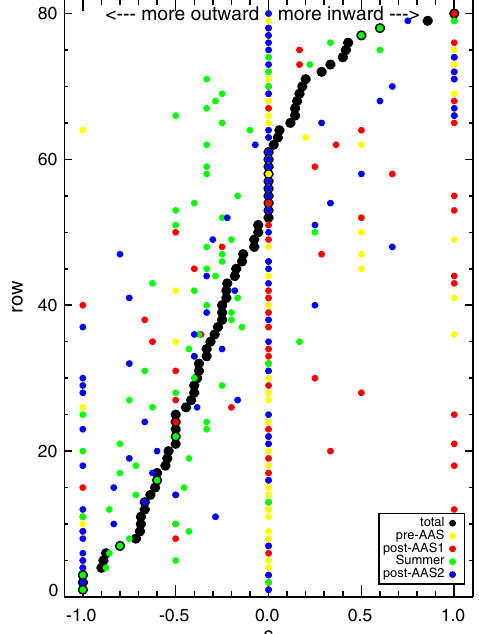
FIG. 2. The metric s (see text). The y axis is, in essence, an assigned teacher number; the teachers have been sorted by s before plotting. Black points are the metric calculated over all instances of that educator for that team ( s ); yellow points are total the metric calculated from the pre-AAS survey (only available for the 2015 class and later), red points are the post-first-AAS survey (post-AAS1), green points are the summer survey, and blue points are the post-second-AAS survey (post-AAS2). The black points are larger than the colored points to make it clearer when the points are overlaid. Points more to the left reflect a more outward focus in the answers; points more to the right reflect a more inward focus. Every person has at least one survey to mine, so when s is exactly 0, it means that the existing (but typically total limited) information suggests a balance between inward and outward motivations. However, many surveys are missing or insufficient from the first 4 years, so when s at individual waypoints is 0, it is more often an indication that there is missing information. There are more red points on the far right and more blue points on the far left; see